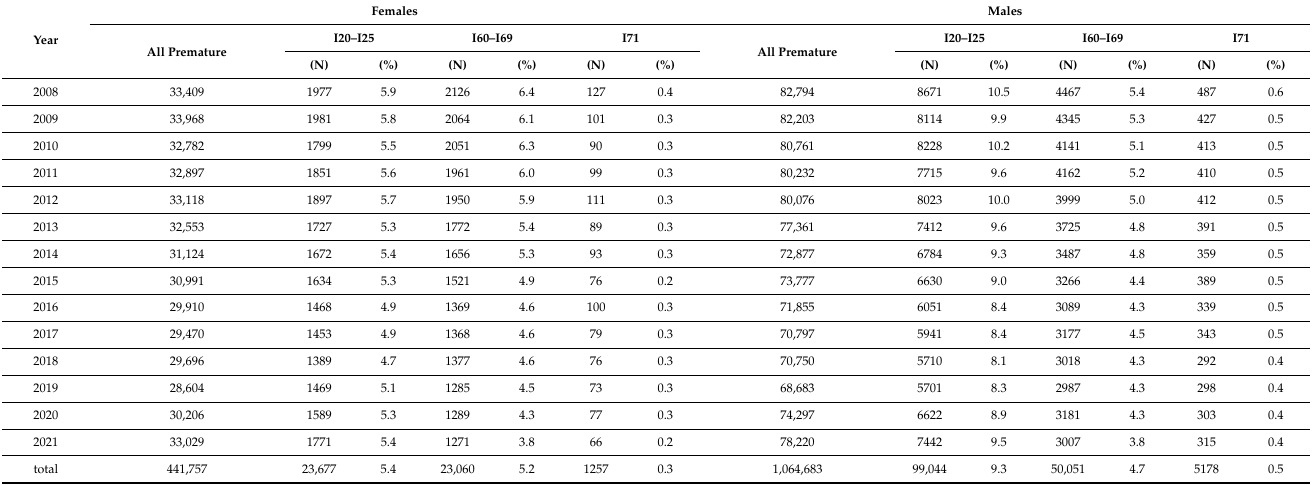
Table 2. Premature deaths due to groups of cardiovascular diseases in Poland by gender, years